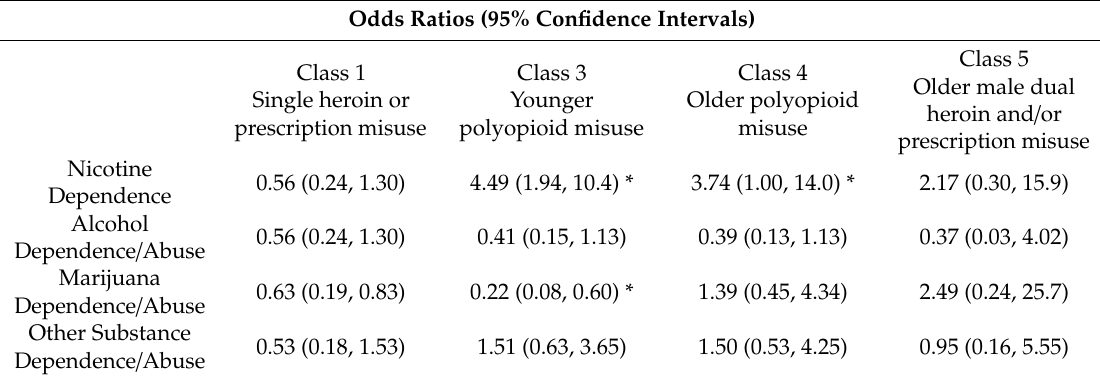
Table 3. Multivariate logistic regression of substance dependence and abuse covariates on five-class solution model using Class 2 or female prescription misuse profile as reference.